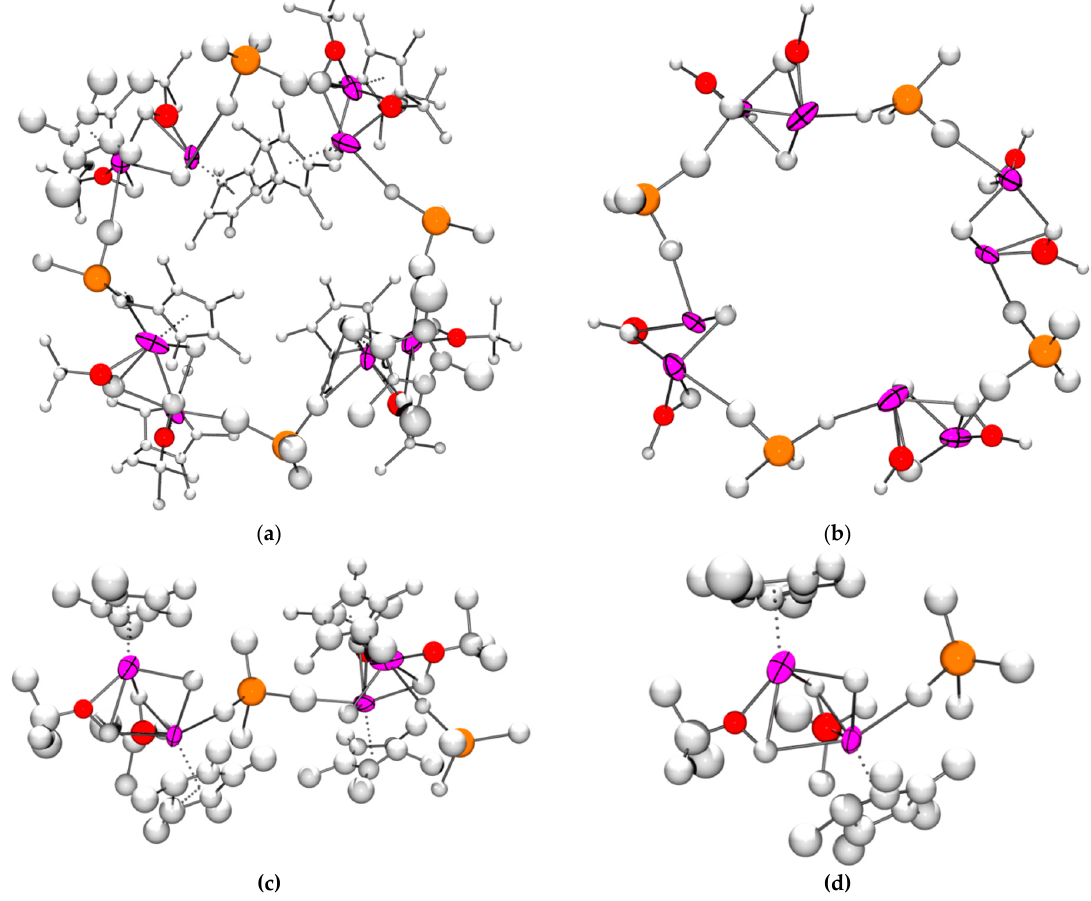
Figure11. Connectivityoverviewofproduct 6 Gd , consideredtobe24-memberedmacrocycliccompound [(Cp*Gd) 2 (Me)(CH 2 O t Bu) 2 (AlMe 4 )] 4 , of the reaction of [Cp*Gd(AlMe 4 ) 2 ] ( 1 Gd ) with TBME. In the ball and stick model, grey represent carbon atoms, magenta represent gadolinium atoms, orange represent aluminum and the red depict the location of oxygen atoms. Hydrogen atoms are omitted for